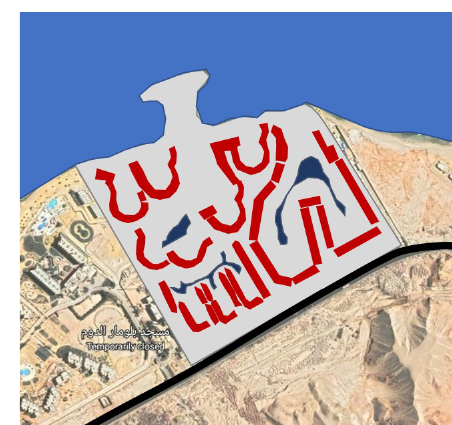
Figure 11. Resort buildings footprint